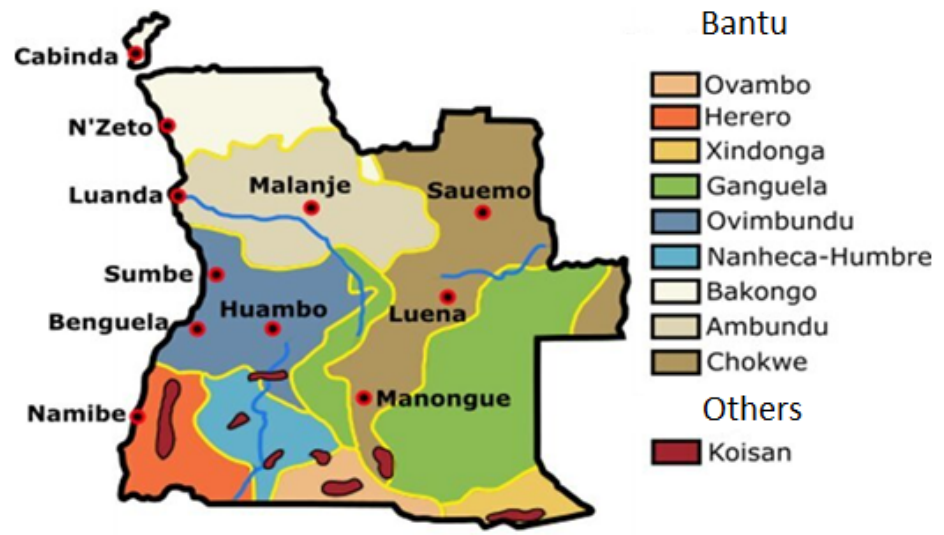
Figure 2. Ethnic groups in Angola. (Source: Instituto Cartográfico de Angola 2020).